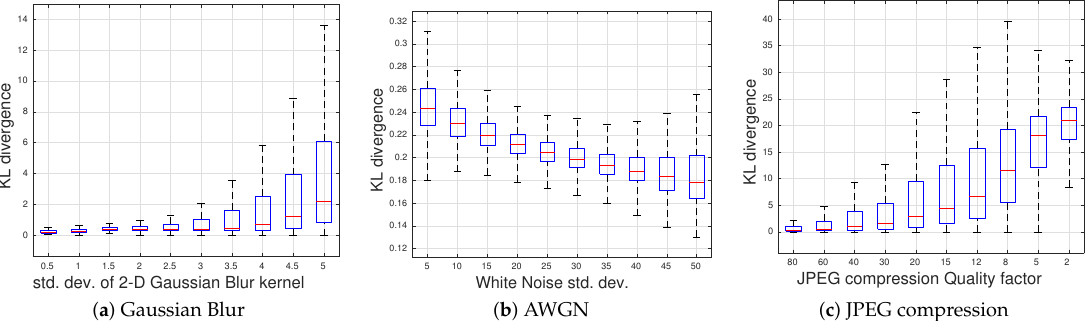
Figure 6. Boxplots of the KL divergence between the 2D empirical distributions of MSGCN coefficients and their multivariate Gaussian fits for three different distortions: ( a ) Gaussian blur, ( b ) AWGN and ( c ) JPEG compression. Outliers were removed from the plots for better